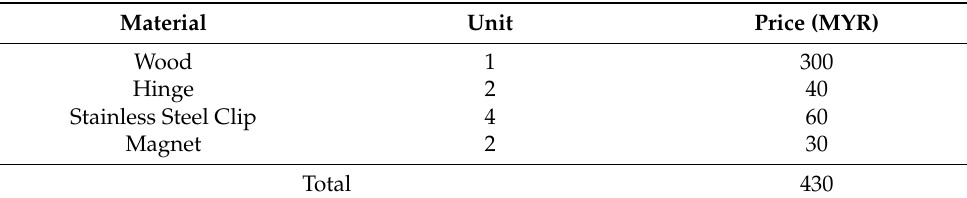
Table 23. Material cost for a single space-saving multipurpose table.